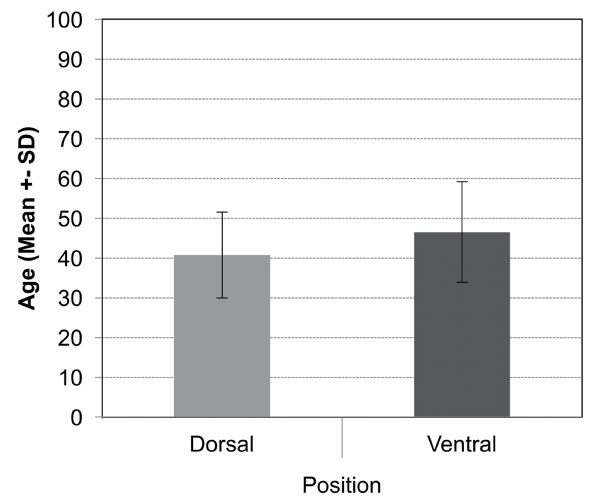
Figure 1 - Mean age of the urologist according to the position preference during